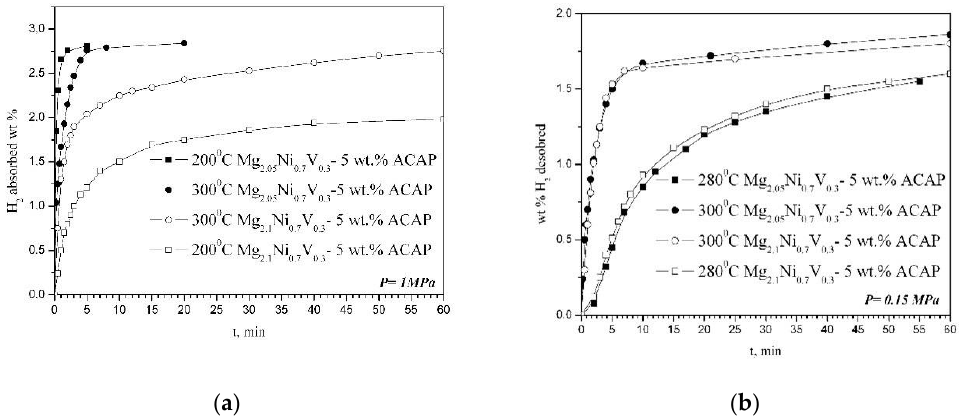
Figure 4. Hydrogen ( a ) absorption and ( b ) desorption kinetic